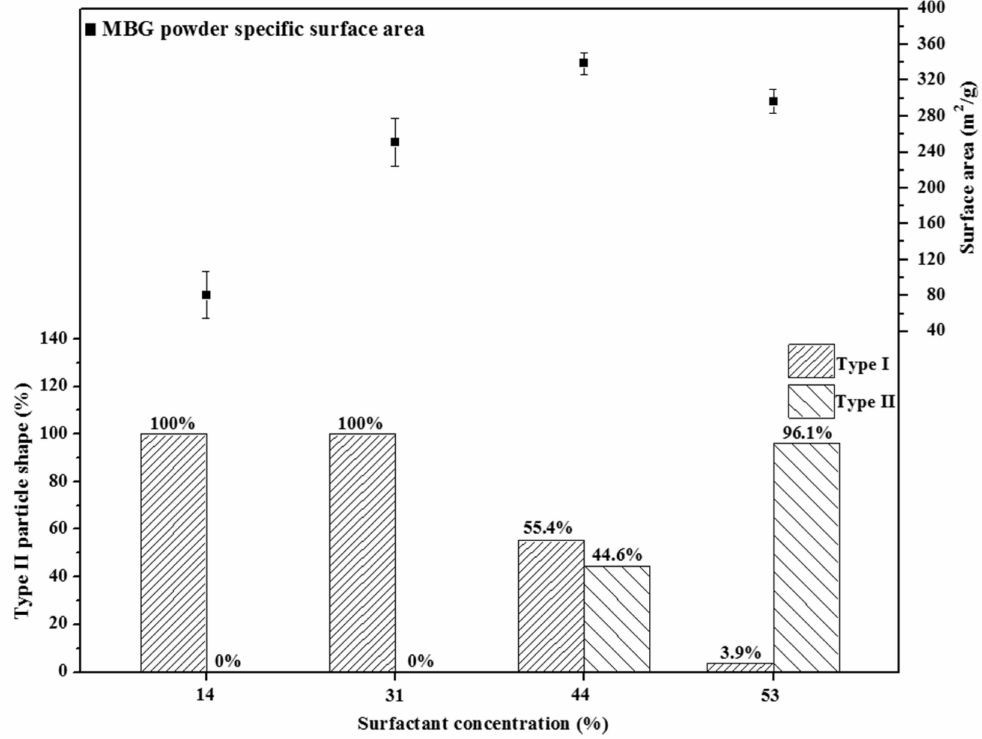
Figure 7. Relationship between particle shape and surface area for various surfactant concentrations treated MBG powders. The percentage values of Type I and II are